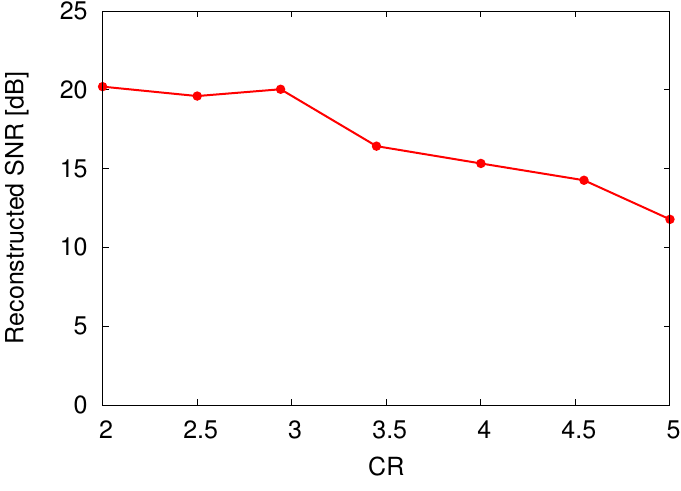
Figure 19. Reconstructed SNR vs. CR at t = 11.1